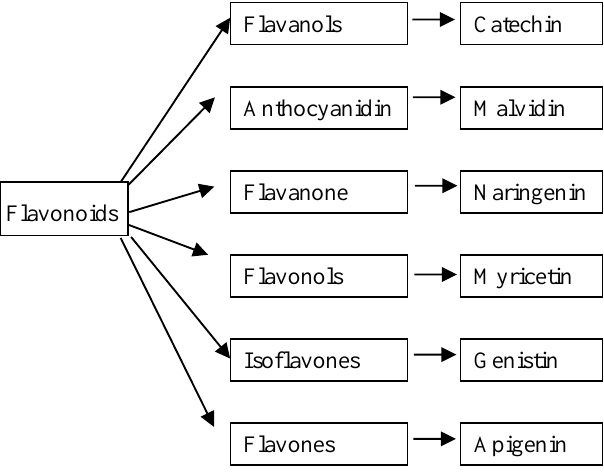
Figure 3. The distribution of Flavonoids found in plants